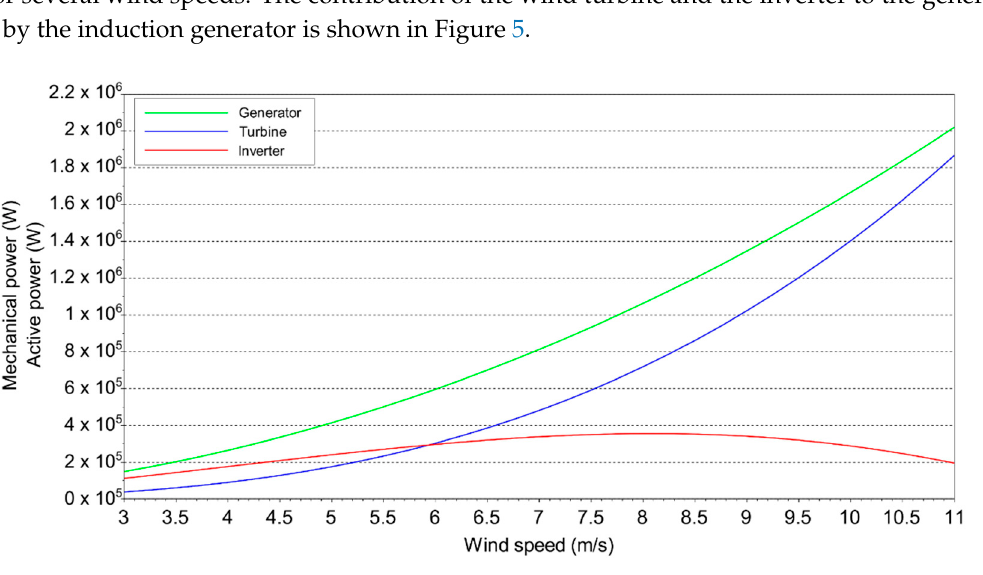
Figure 5. Active power as a function of wind speed.